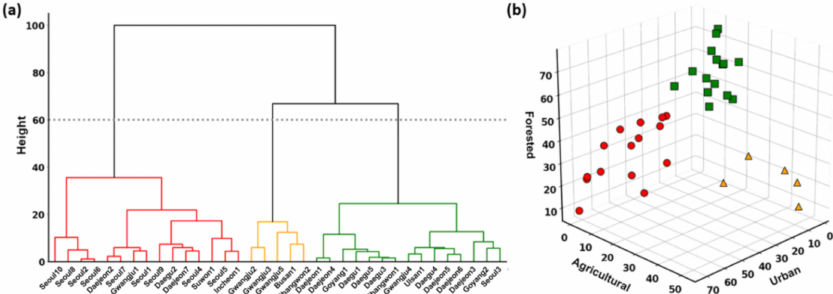
Figure 2. Clustering results of 35 watersheds, named metropolitan area with numbering, based on six land-cover categories. ( a ) Dendrogram exhibiting three clusters generated from hierarchical agglomerative cluster analysis. The horizontal dashed gray line represents the height for dendrogram partitioning, (D link / D max ) · 100 > 60. ( b ) Percentage (%) of the dominant land-cover type for each of the three clusters. The red circle, yellow triangle, and green square denote watersheds that are urban-dominated, agriculture-dominated, and forest-dominated,